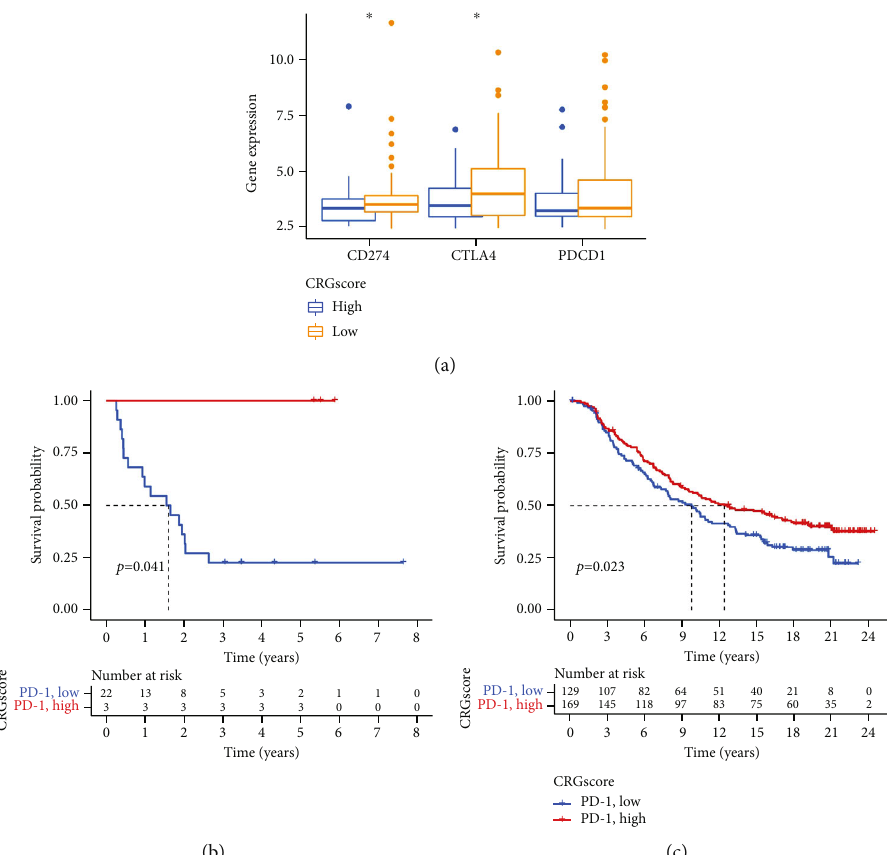
Figure 8: The function of the CRG score in determining the e ff ectiveness of immunotherapy. (a) Variation in ICB gene expression across groups with high and low CRG scores ( ∗∗∗ P < 0 : 001 and ∗∗ P < 0 : 01 ). (b) Survival curves comparing patients in groups with high and low CRG scores treated with anti-PD-L1 in the GSE93157 cohort. (c) Survival curves comparing patients in groups with high and low CRG scores treated with anti-PD-L1 in the IMvigor210 cohort. CRG: cuproptosis-related gene; ICB: immune checkpoint